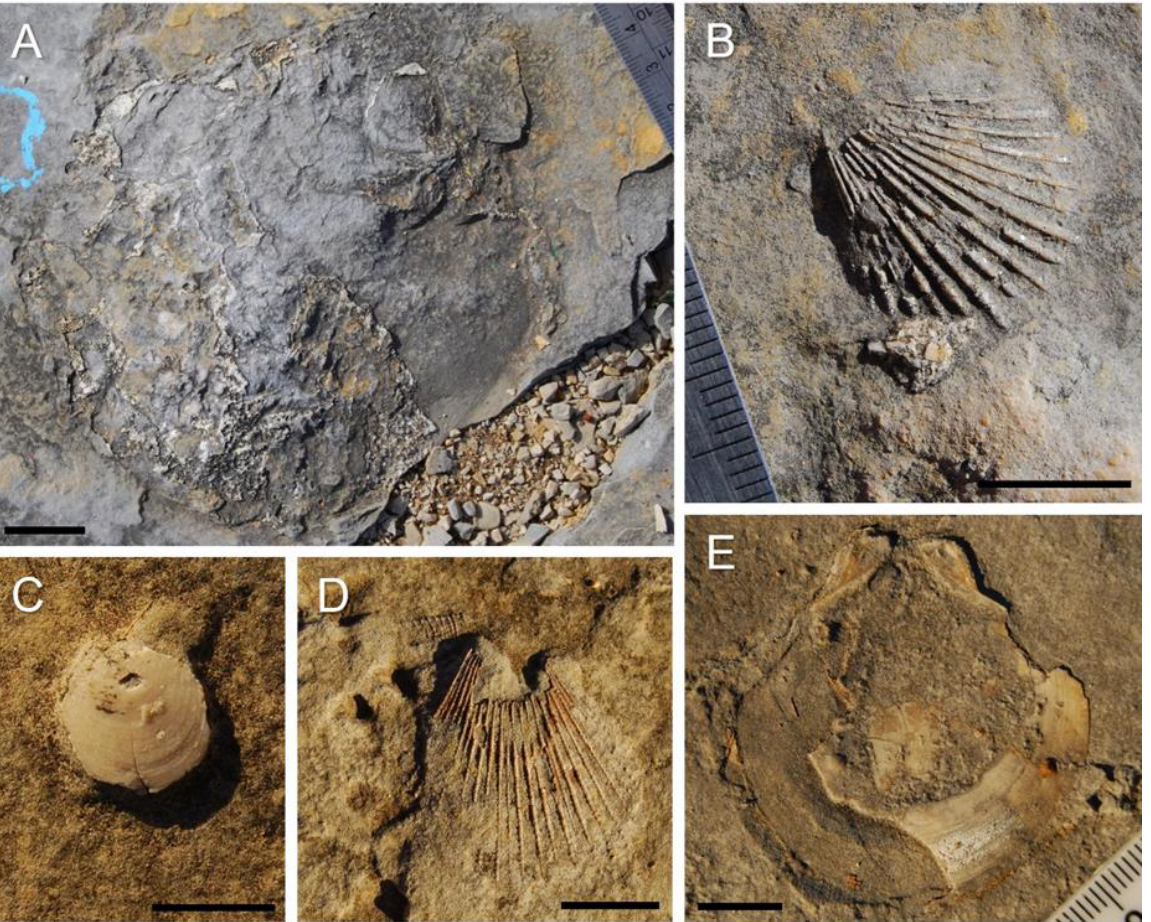
Figure 5. Selected bivalve records from Cabeço da Ladeira site (photos from RP): ( A ) Eopecten spondyloides (Roemer, 1836), scale bar is 20 mm; ( B ) Spondylopecten palinurus (d´Orbigny, 1850); ( C ) Propeamussium laeviradiatum (Waagen, 1867), scale bar: 5 mm; ( D ) Praechlamys textoria (Schlotheim, 1820); ( E ) Entolium corneolum (Young and Bird, 1828). Scale bar is 10 mm unless otherwise stated .